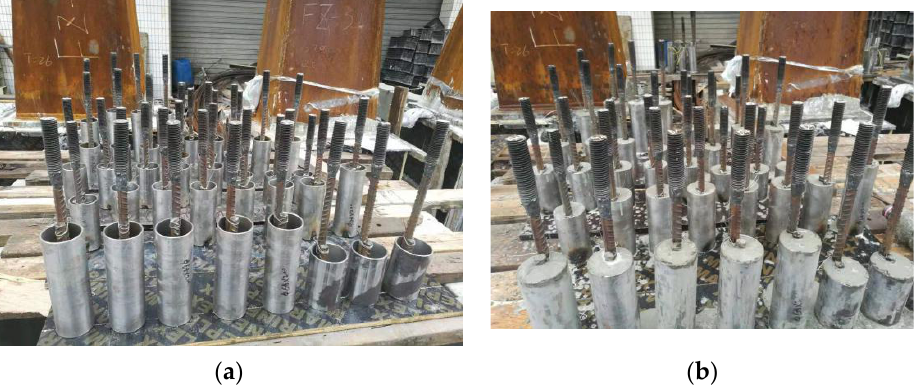
Figure 4. Specimens ( a ) before and ( b ) after the grouting material was poured in.